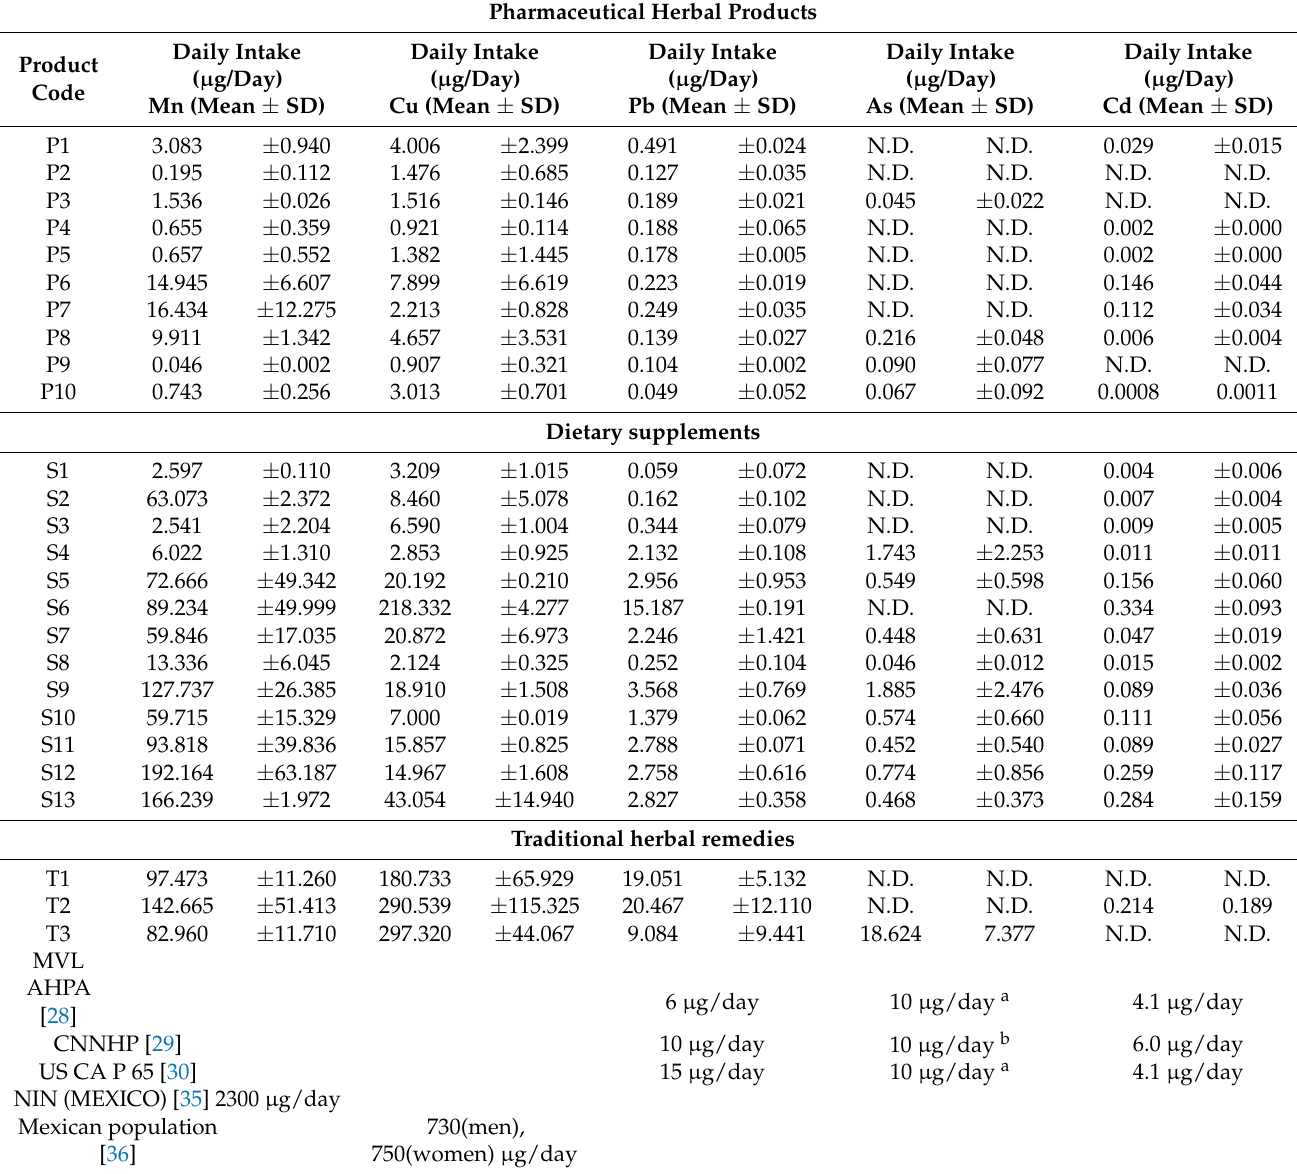
Table 2. Daily intake dose ( µ g/day) of different metals in pharmaceutical herbal products, dietary supplements, and traditional herbal remedies containing Ginkgo biloba